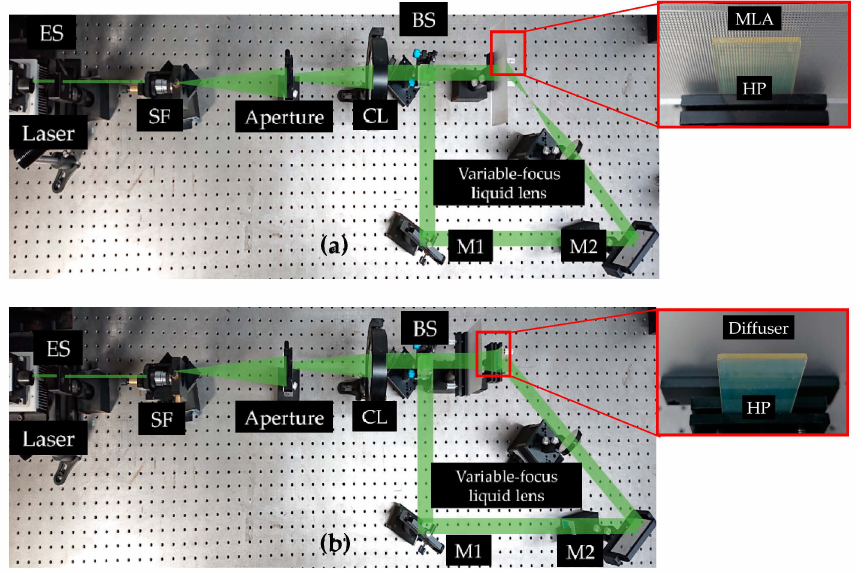
Figure 5. Experimental setups for the two-step recording of MHOE: ( a ) Recording of MLA, ( b ) recording of a diffuser. ES, electronic shutter; SF, spatial filter; CL, collimating lens; BS, beam splitter; M1, M2, mirror; HP, holographic plate.